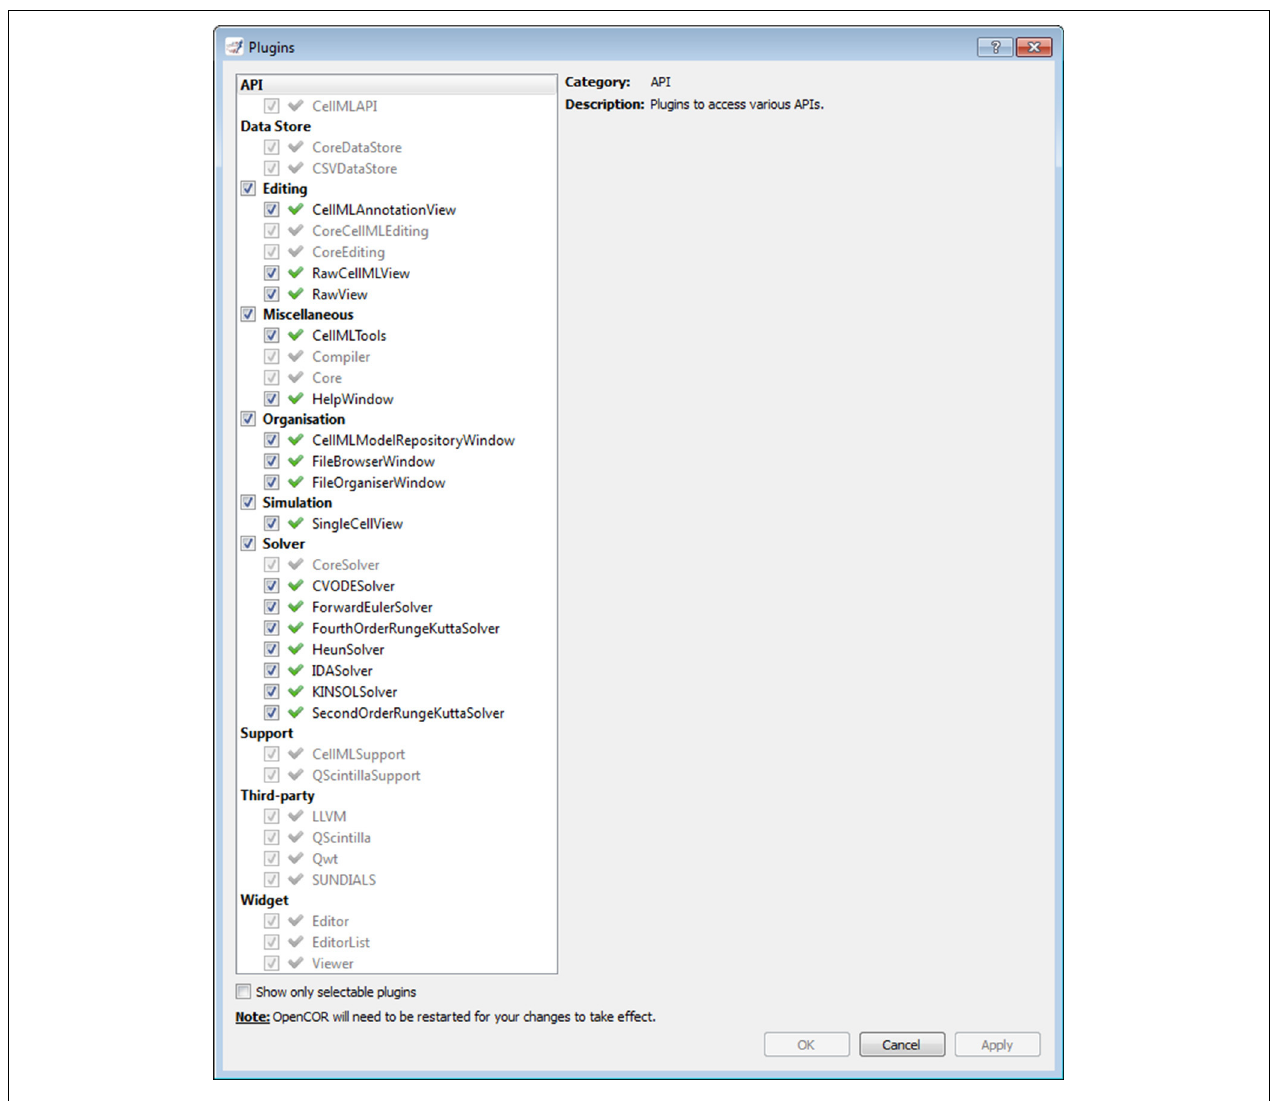
FIGURE 2 | Plugins window. Several plugins are available, grouped in different categories. Grayed out plugins cannot be manually selected since they refer to a plugin that provides some functionality